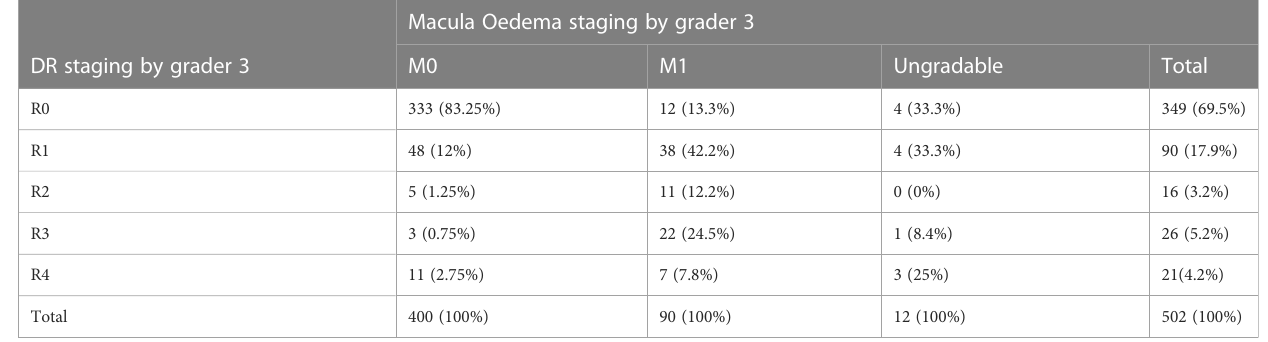
TABLE 7 Diabetes retinopathy staging against macula oedema staging by grader 3.